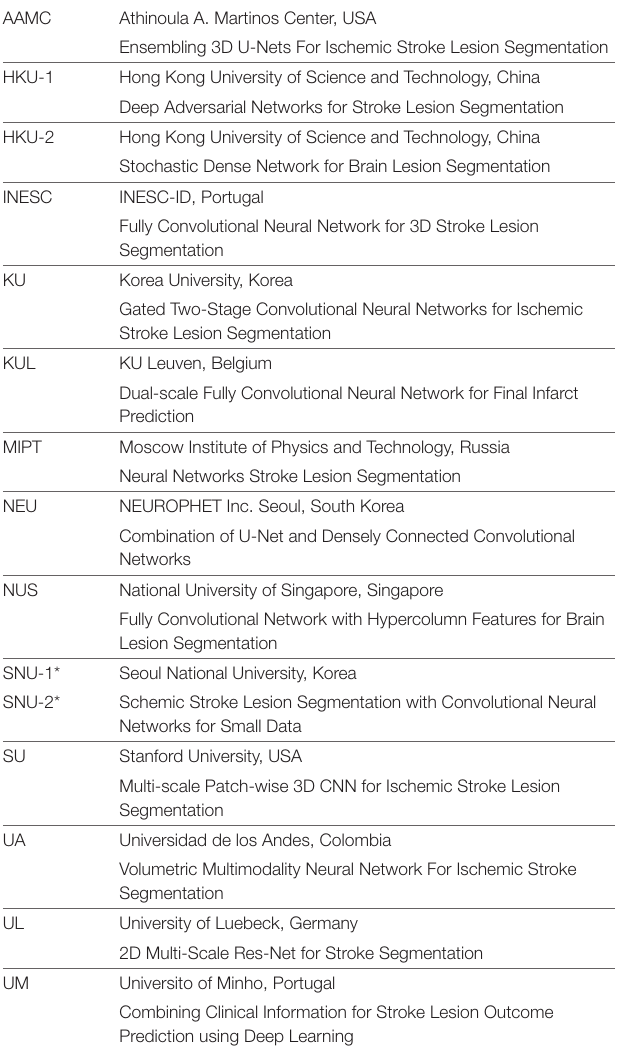
TABLE 1 | Participants of ISLES 2016 (more details and main features of each method see Appendix ISLES16-A1 to ISLES16-A7).